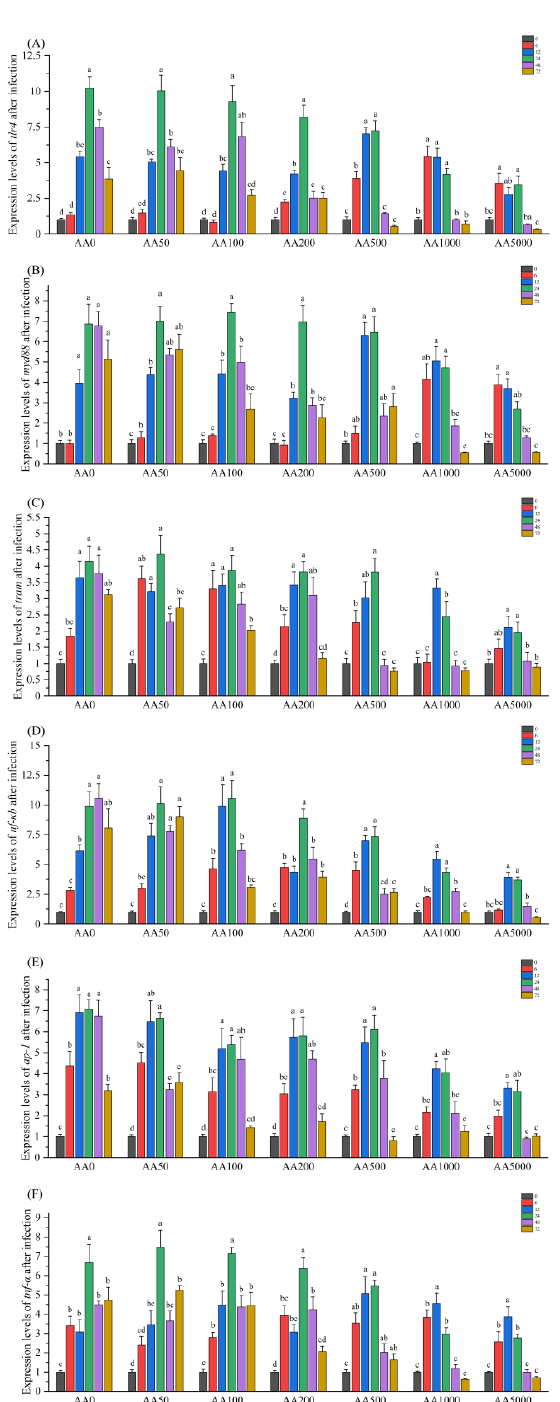
Figure 4. Expression levels of tlr4 , myd88 , tram , nf-κb , ap-1 and tnf-α in the digestive gland of abalone ( Haliotis discus hannai ) in response to Vibrio Parahemolyticus after a 100-day feeding trial. ( A ) tlr4 : toll-like receptor 4 ; ( B ) myd88 : myeloid differentiation primary response gene 88 ; ( C ) tram : trif-related adaptor molecule ; ( D ) nf-κb : nuclear factor-κb ; ( E ) ap-1 : activator protein 1 ; ( F ) tnf-α : tumor necrosis factor α . Gene expression levels are presented as the fold-change compared with the respective control group (AA0) (set to 1) at 0 h, 6 h, 12 h, 24 h, 48 h and 72 h post-infection. All data expressed as mean ± SE ( n = 3). The different lowercase letters indicate significant differences ( p < 0.05).